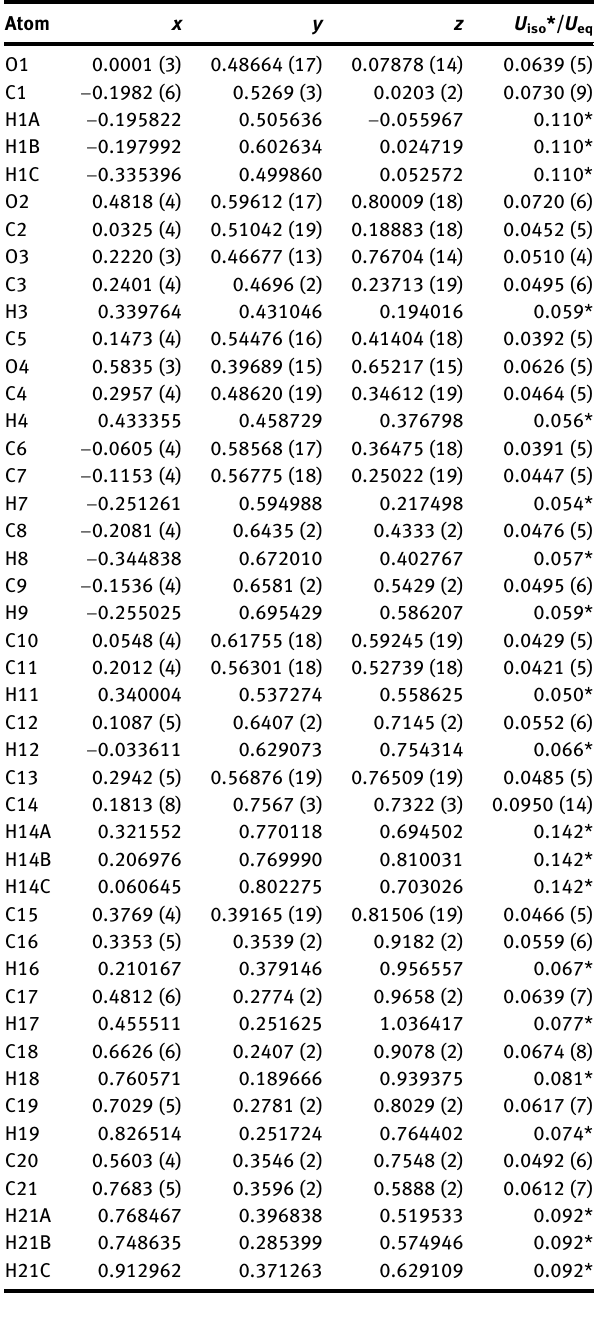
Table  : Fractional atomic coordinates and isotropic or equivalent isotropic displacement parameters (Å 